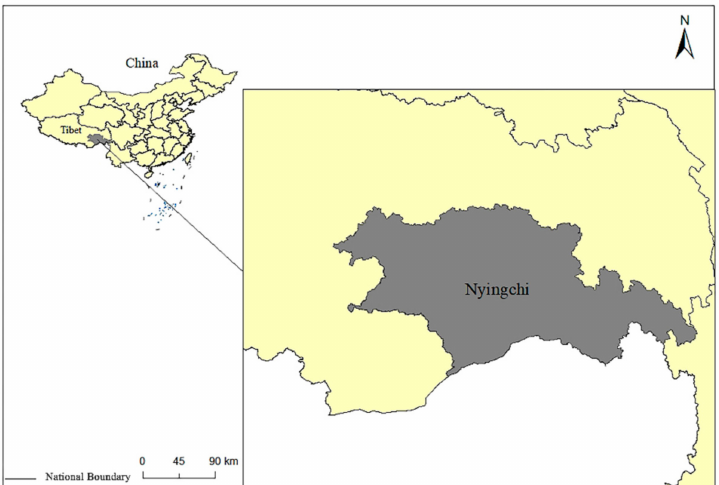
Figure 1. Location map of Nyingchi. Note: The map is based on the standard map of the Map Technical Review Centre of the Ministry of Natural Resources of China (Number: GS (2019)4342), with no modifications to the base map. Map-making by the author. Table 1. Economy data of Nyingchi from 2010 to 2020 (unit: CNY billion).